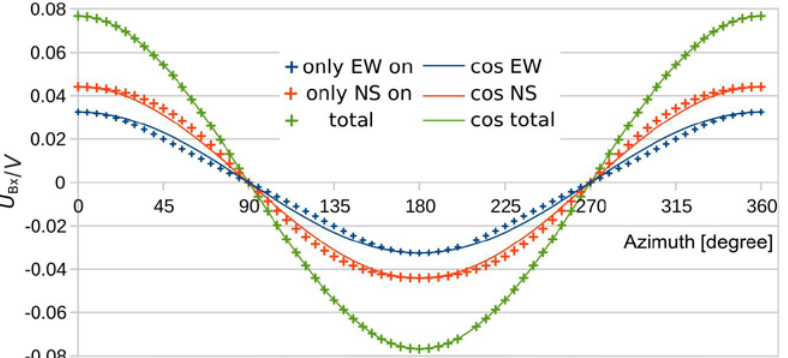
Figure 13. Partial and total response to 1 m / s flow as a function of the flow direction. The simulated